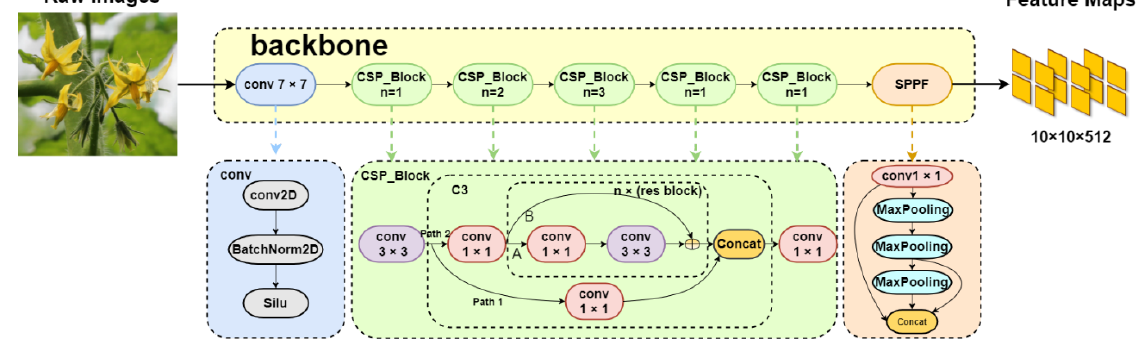
Figure 4. Local structure of the CSPNet backbone network.